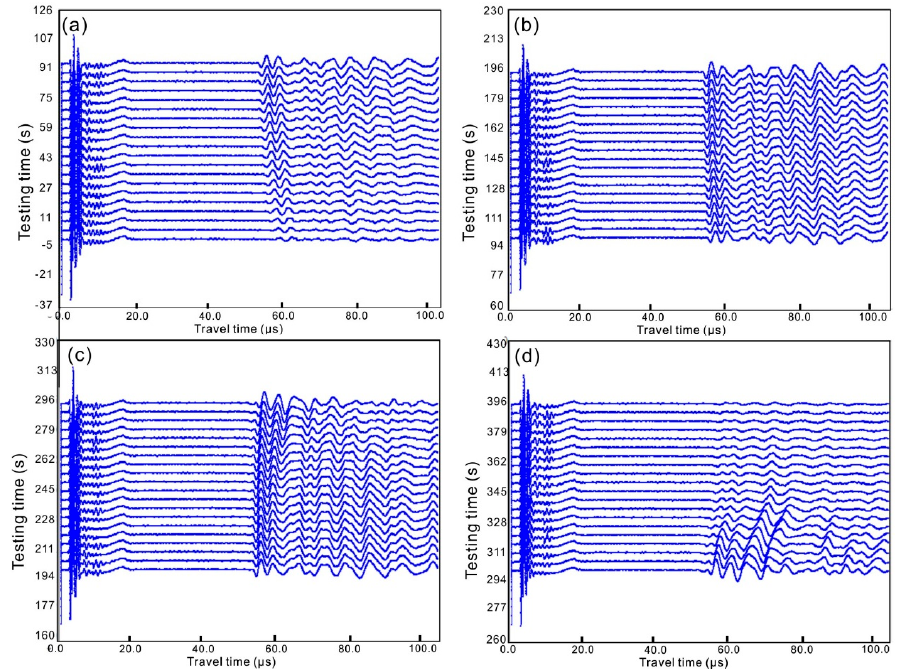
Figure 11. Waveform of S-wave for granite subjected to 100 F–T cycles during uniaxial deformation. The labels ( a – d ) indicate the four parts of the full waveform; the duration of the testing was 0–395 s.